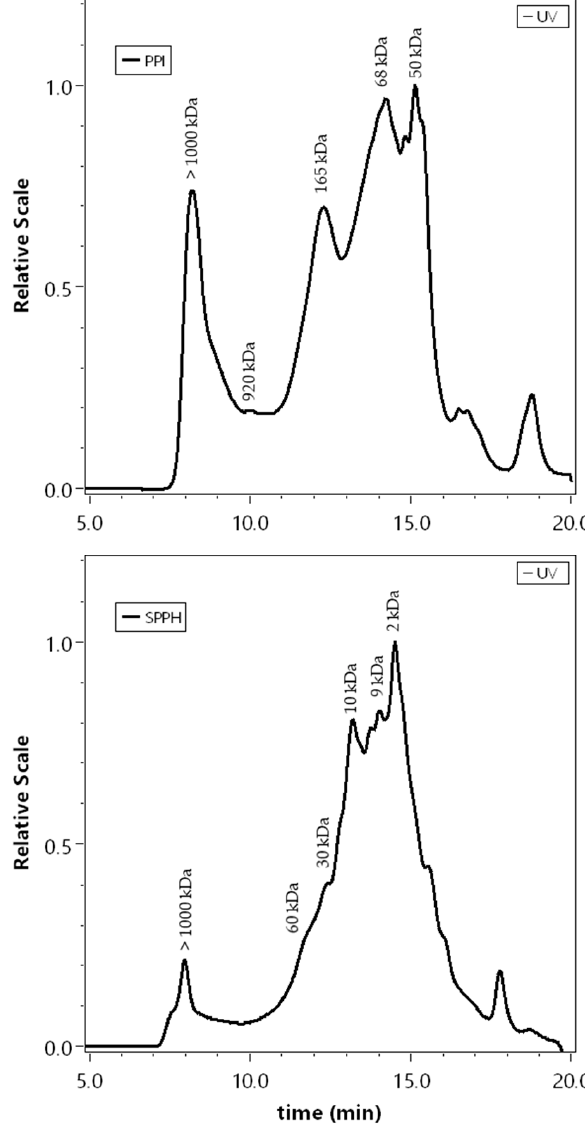
Figure 1. Size-exclusion chromatograms of PPI and SPPH.